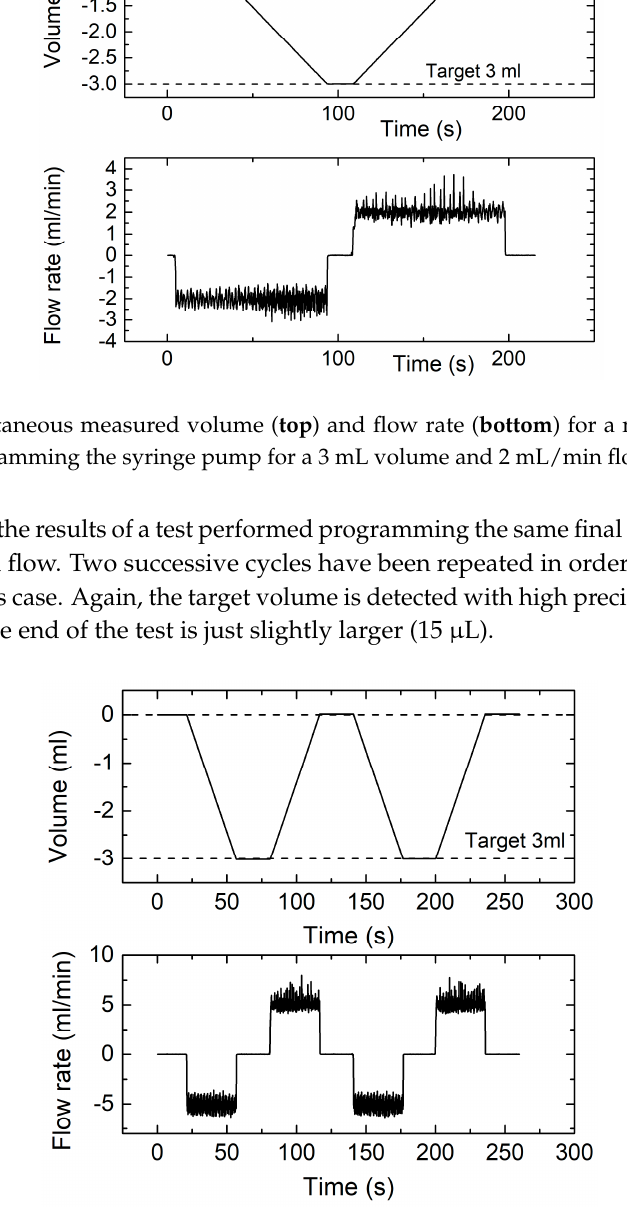
Figure 11. Instantaneous measured volume ( top ) and flow rate ( bottom ) for two successive measurement cycles obtained for 3 mL volume and 5 mL/min flow rate.